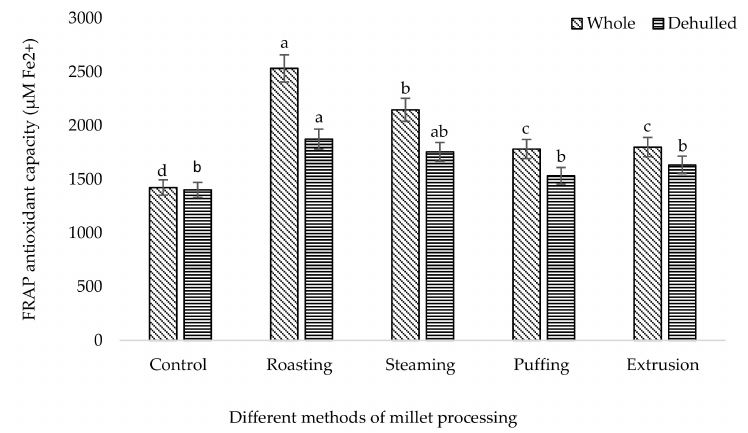
Figure 2. FRAP antioxidant capacity of processed broomcorn millet. FRAP: ferric reducing antioxidant power. The values are the mean ± SE. ( n = 3). Di ff erent lowercase letters within the bar indicate significant di ff erences ( p < 0.05) according to ANOVA.